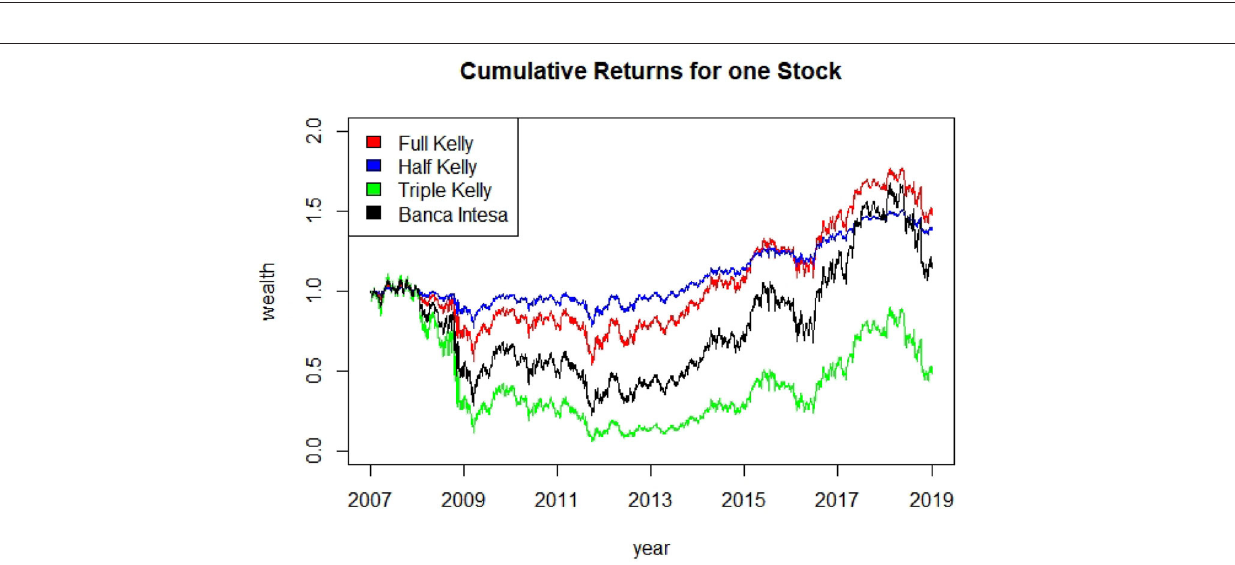
FIGURE 2 | Mean log-wealth obtained for the different Kelly strategies in the 10,000 trades case.